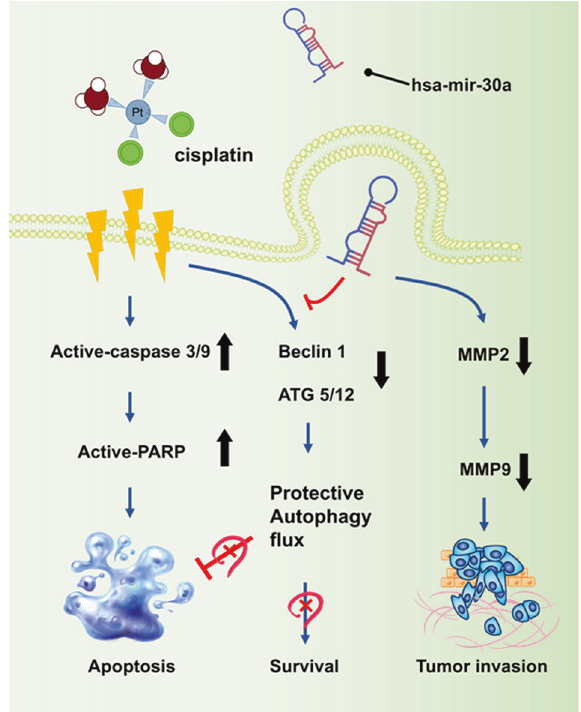
Fig. 9 Proposed model of the clinical bene fi ts of hsa-miR-30a-3p in BC treatment. Cisplatin is a fi rst-line chemotherapeutic drug in BC and has antitumor effects in promoting cell apoptosis; however, its function of triggering protective autophagy is concerning in BC treatment [8]. In combination with miR-30a-3p treatment, the reduction in MMP2 and MMP9 leads to the suppression of cell migration and invasion abilities in vitro and muscle invasion in vivo. Furthermore, miR-30a-3p directly suppresses ATG5/12 and Beclin 1 expression. Cotreatment with lenti-miR-30a-3p can circumvent the induction of cisplatin-mediated protective autophagy, thus enhan- cing the chemosensitivity of BC to cisplatin. In sum, miR-30a-3p may serve as a potential tool of miRNA-based cancer therapy in BC